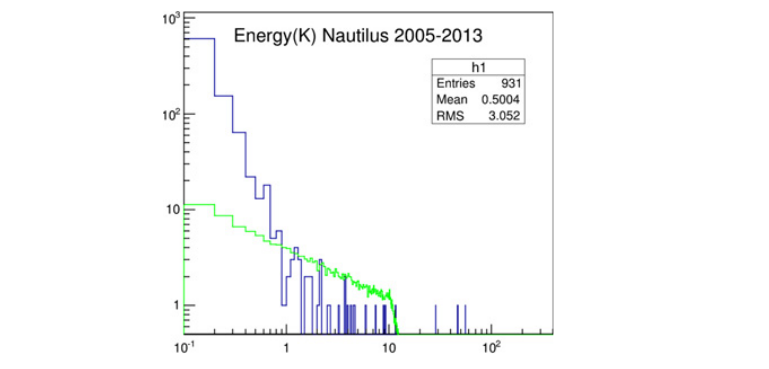
Figure 2. Vibrational energy distribution of the NAUTILUS events, after the cuts discussed in the text. The lower plot (in green) is the result of a Montecarlo simulation for (cid:5)(cid:4) ( M ) = 0.004 and is normalized to